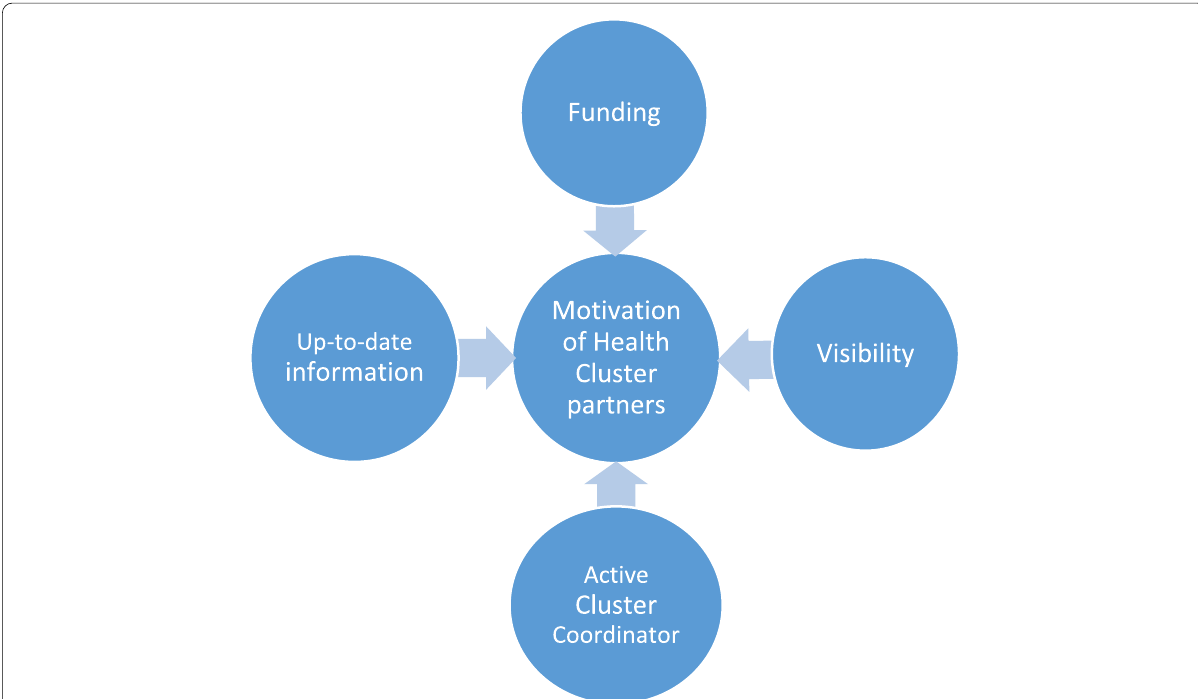
Fig. 1 The main motivations of health stakeholders to actively participate in the Health Cluster meetings in